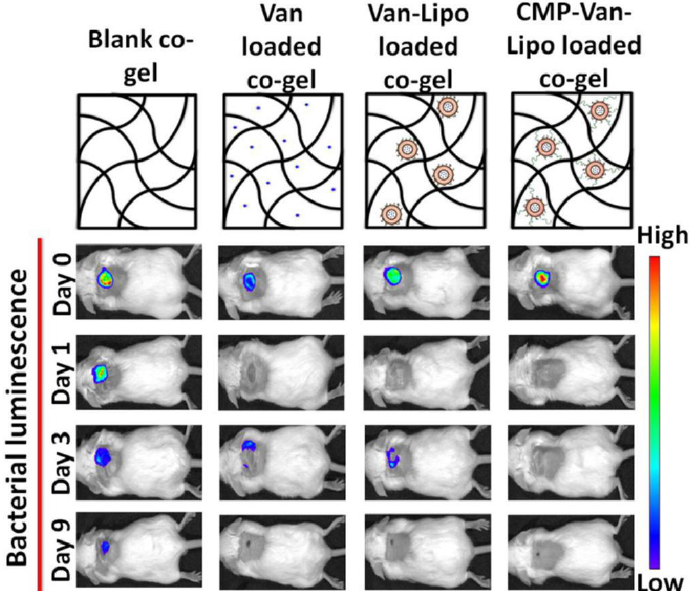
Figure 6. Lumina images for mouse punch biopsy wounds inoculated with luminescent Staphylo- coccus aureus followed by treatment with different groups: blank co-gels: hydrogel without Vancomycin; Van-loaded co-gels: hydrogel with non-encapsulated Vancomycin; Van-Lipo loaded co-gels: hydrogel with Vancomycin-loaded liposomes; CMP-Van-Lipo: hydrogel of collagen mimetic peptide conjugated vancomycin-loaded liposomes. Figure reproduced with permission from Thapa and co-workers [78].